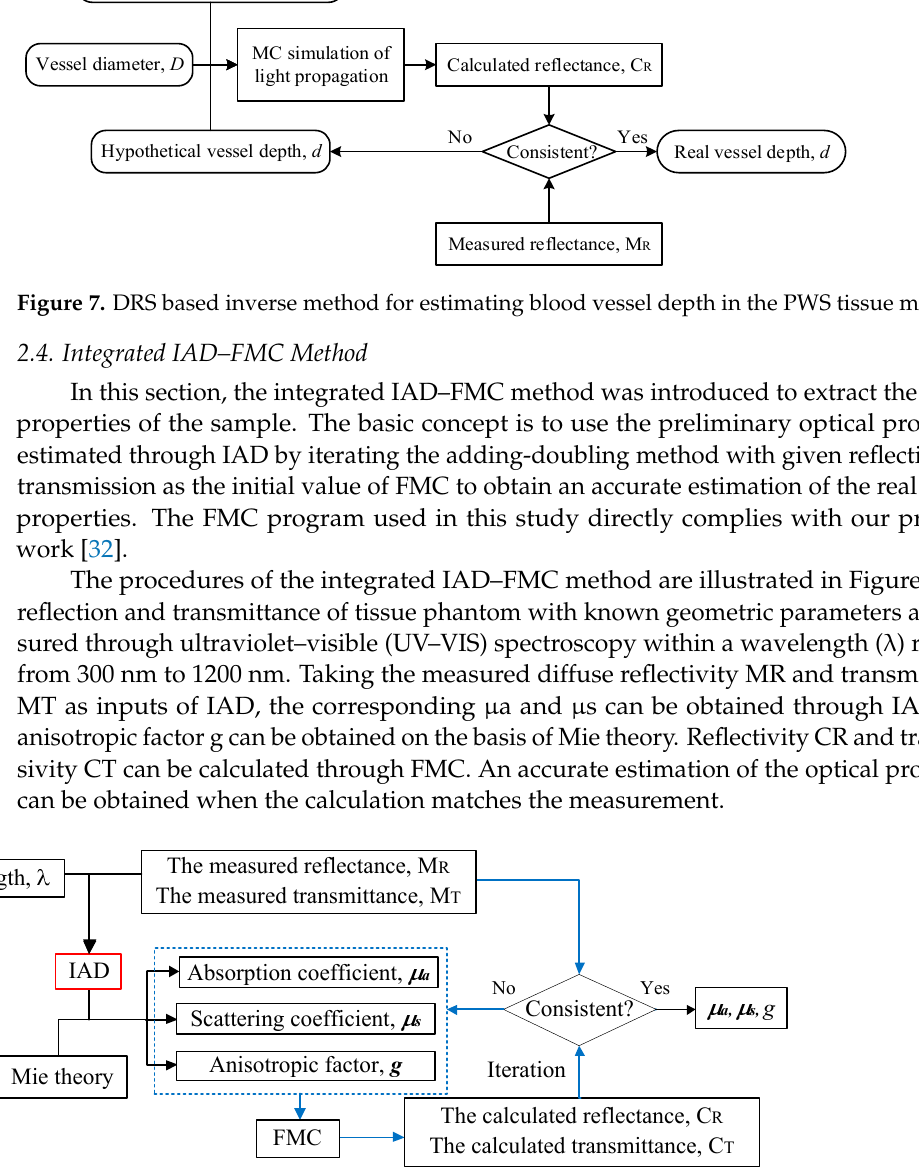
Figure 8. IAD–FMC coupling method.